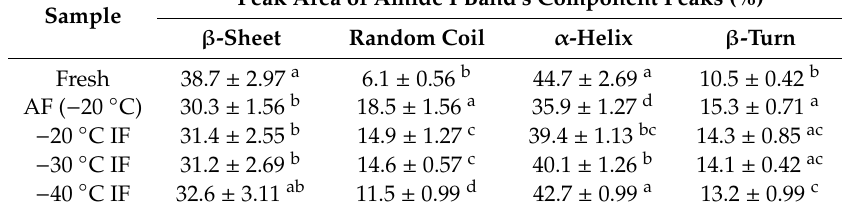
Table 3. Percentage area contribution of amide I band component peaks of fish samples under di ff erent freezing